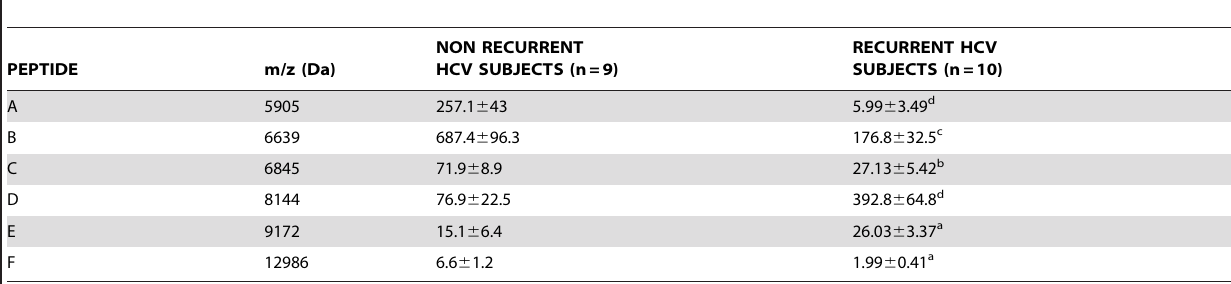
Table 2. Intensity values ( m A) of peaks showing different patterns of expression in the two groups of patients.